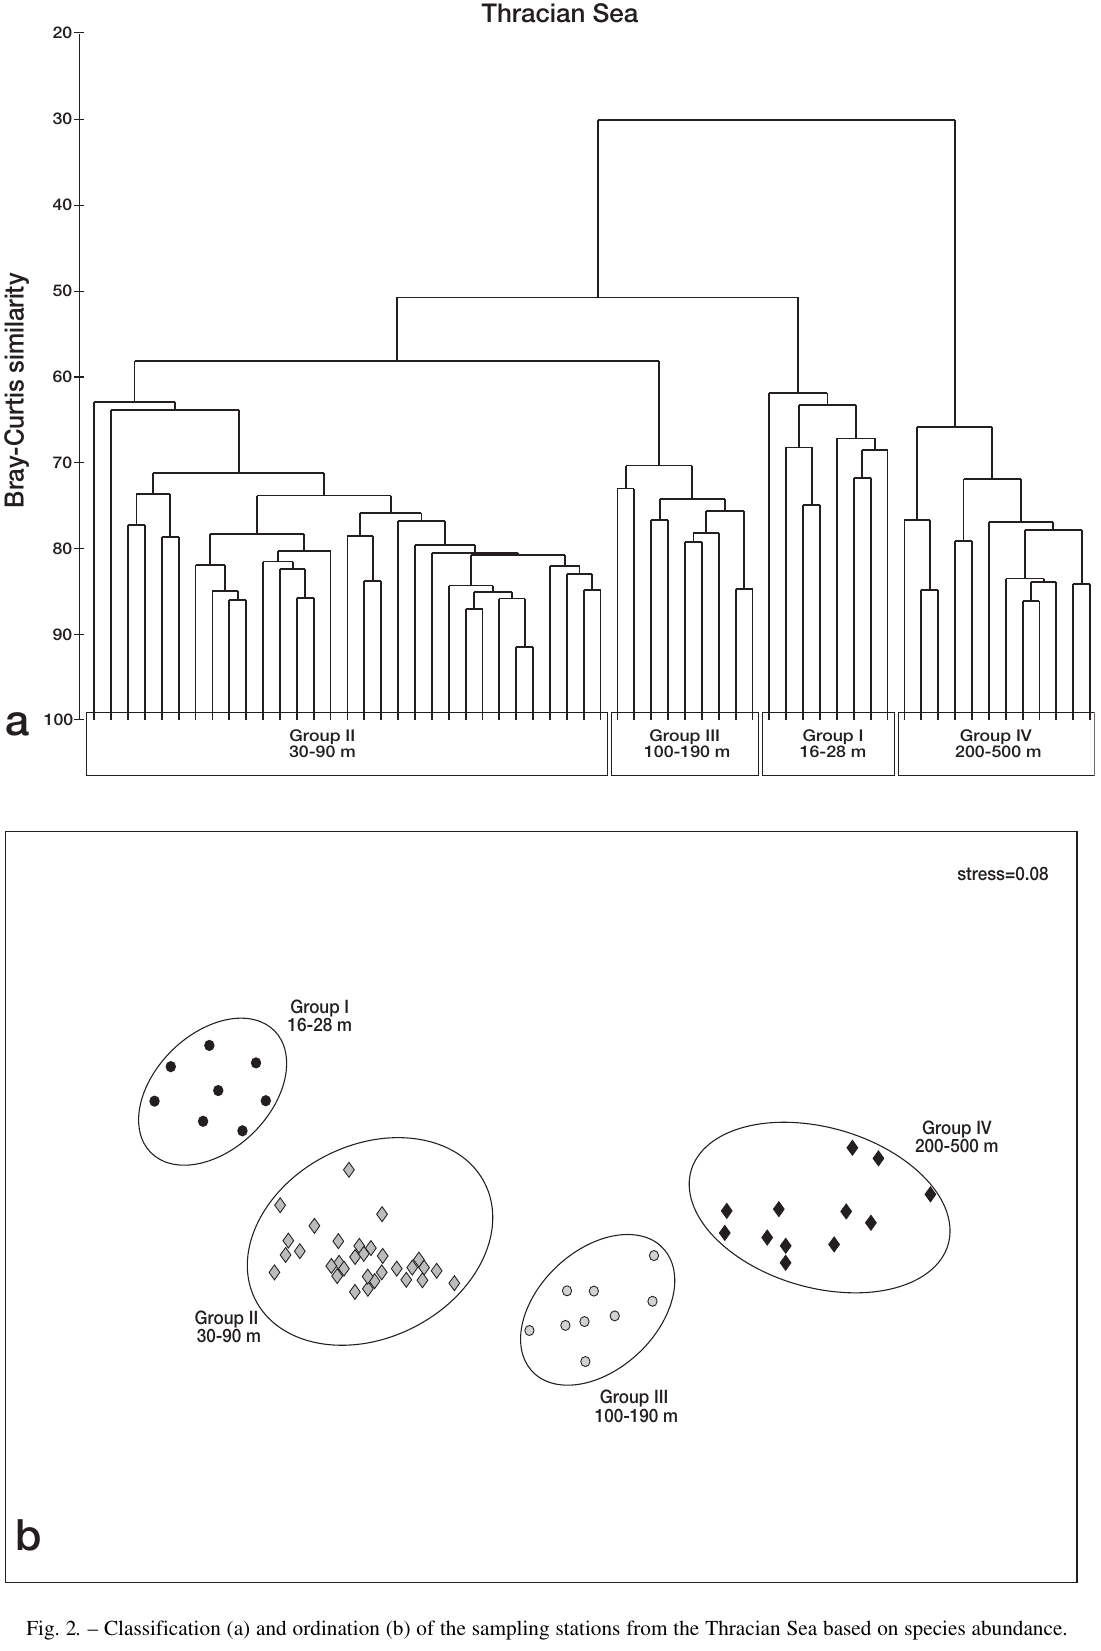
Fig. 2 . – Classification (a) and ordination (b) of the sampling stations from the Thracian Sea based on species